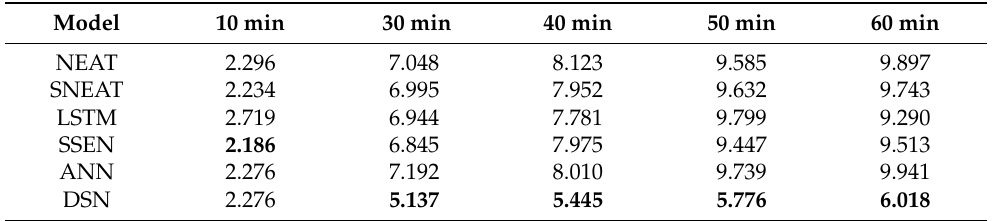
Table 6. CRPS of different NN models distributional forecast (normalized by P max ag ) of all ramps over the year of